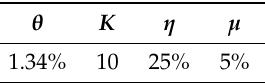
Table 3. Supplementary parameters used in the computations of the ALM comparison.